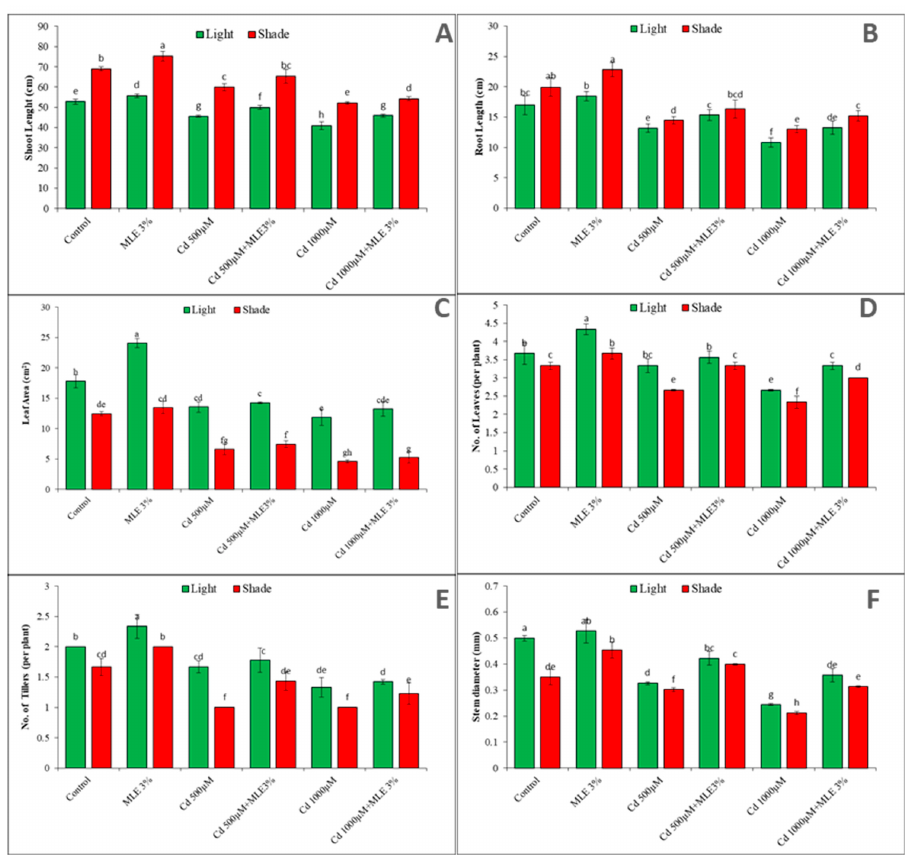
Figure 1. Effect of MLE application on morphological attributes of plant: ( A ) shoot length ( B ) root length ( C ) leaf area ( D ) Number of leaves ( E ) Number of tillers and ( F ) stem diameter, with and without Cd stress under light and subdue light. Different letters above bars represents significant differences ( p < 0.05) at each measured point. Values represent mean ± SE of three replicates of each treatment.